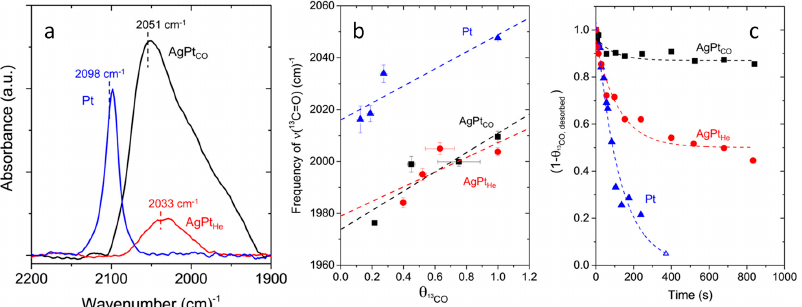
Figure 14. ( a ) infrared spectra of adsorbed 12 CO following the purge of gas-phase 12 CO with He (101 kPa, 30 cm 3 min − 1 , 303 K) on Pt (blue), AgPt CO (black), and AgPt He (red). Spectra are the average of 128 scans with a 4 cm − 1 resolution. Dotted lines are intended to show the peak position for each spectrum. ( b , c ) Peak position of ν (C=O) for 13 CO as a function of the coverage of adsorbed 13 CO ( θ 13 CO ) (total of 1 kPa CO, 100 kPa He, 100 cm 3 min − 1 , 298 K) and change in the coverage of θ 13 CO as a function of time during exchange with 12 CO on Pt (blue triangles) and CO-treated (black squares) and He-treated (red circles) AgPt octahedral particles (0.2 kPa 12 CO, 100 cm 3 min − 1 , 298 K; surfaces pre-saturated with 13 CO). Solid lines in ( b ) represent a linear fit to the data, and dashed lines in panel c represent the fit of θ 13 CO as a function of time. Adapted with permission from ACS Catalysis, N. M. Wilson, Y.-T. Pan, Y.-T. Shao, J.-M. Zuo, H. Yang, D. W. Flaherty, Direct Synthesis of H 2 O 2 on AgPt (2018) American Chemical